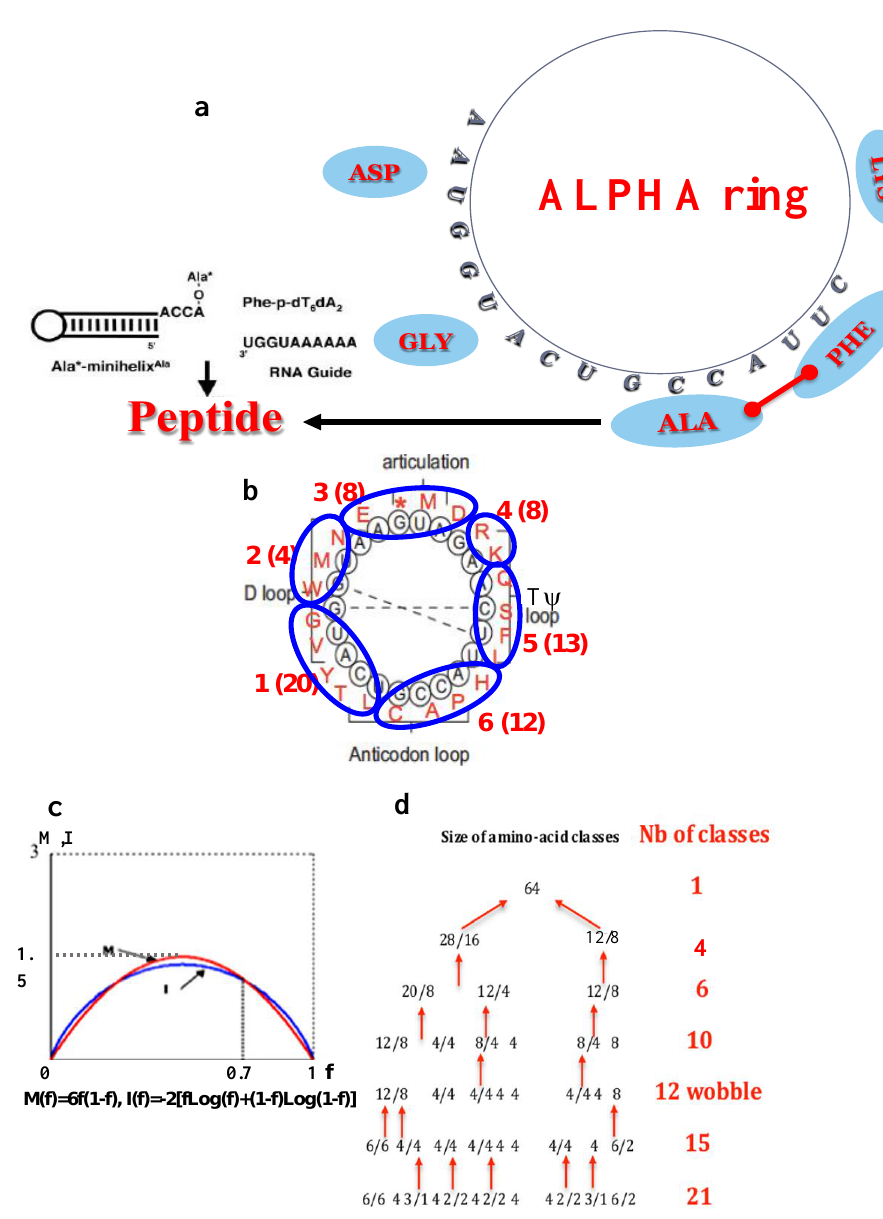
Figure 7. ALPHA ring as ribosome ancestor. ( a ) Primitive translation machinery centered on ALPHA ring with synthesis of Ala-Phe peptide on UGGUAA RNA guide [78] or on its complement in ALPHA GCCAUU. ( b ) ALPHA can be divided into six sub-sequences corresponding to the codons classes candidates for the second step of the descending partition, which follows ( c ) the min-max principle: “mean mutation error M equals information I” [79] and gives at step 4 ( d ) the “wobble” partition coding for the 11 early assigned amino acids plus a group of codons assigned to late amino acids